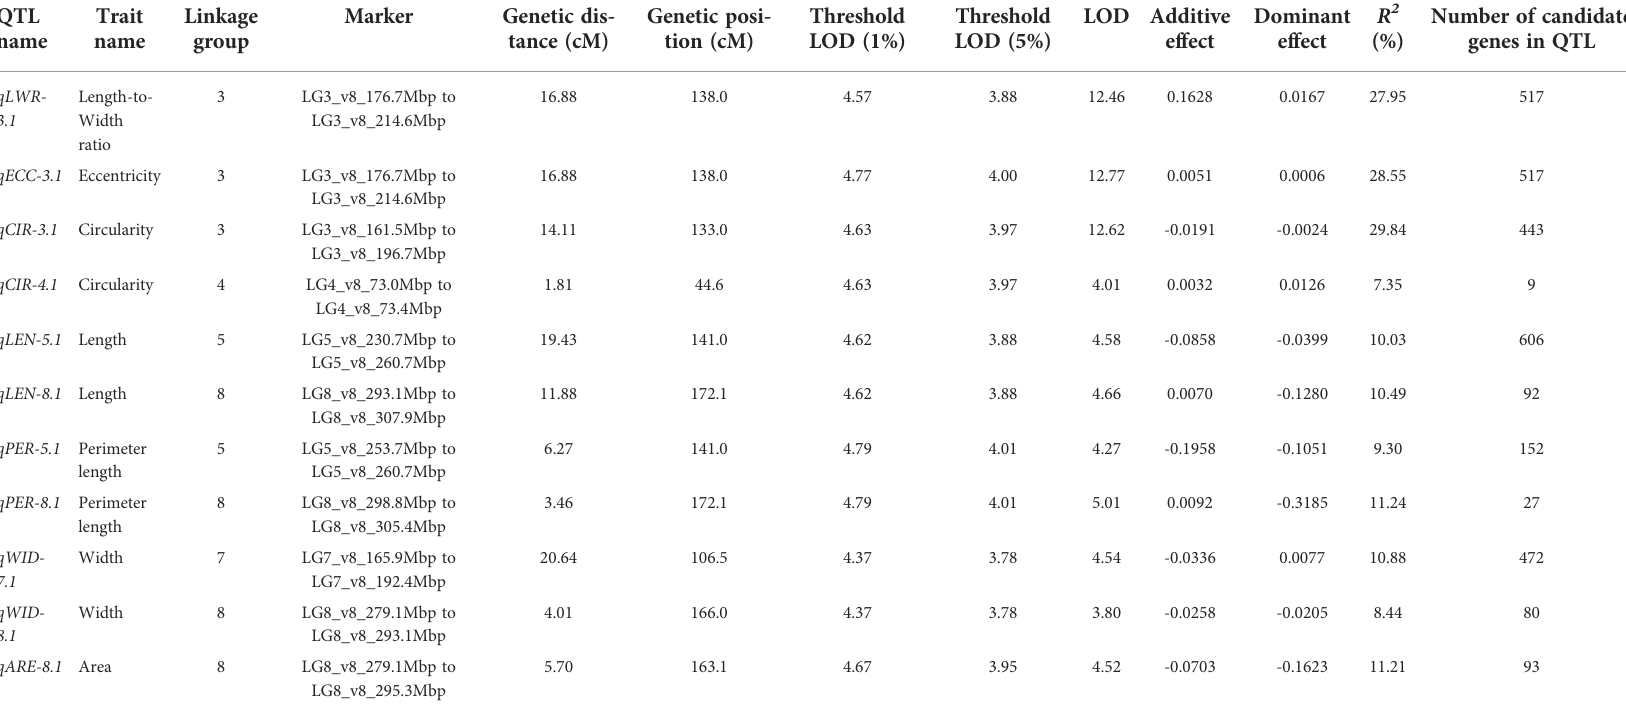
TABLE 5 QTL detected by composite interval mapping in the F 2 population derived from the ‘ Oilseed ’ × ‘ UenoyamaMaruba ’